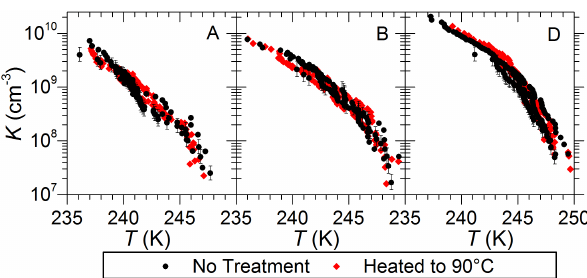
Fig. 5. Cumulative nucleus spectrum for soil dusts A, B and D in the <11µm fraction determined from the pico-DFE. For clarity, er- ror bars are only shown for one size bin in each graph. The uncer- tainty in temperature measurement was ± 0.4K. Data for sample C were not obtainable, owing to insufficient soil dust to perform the